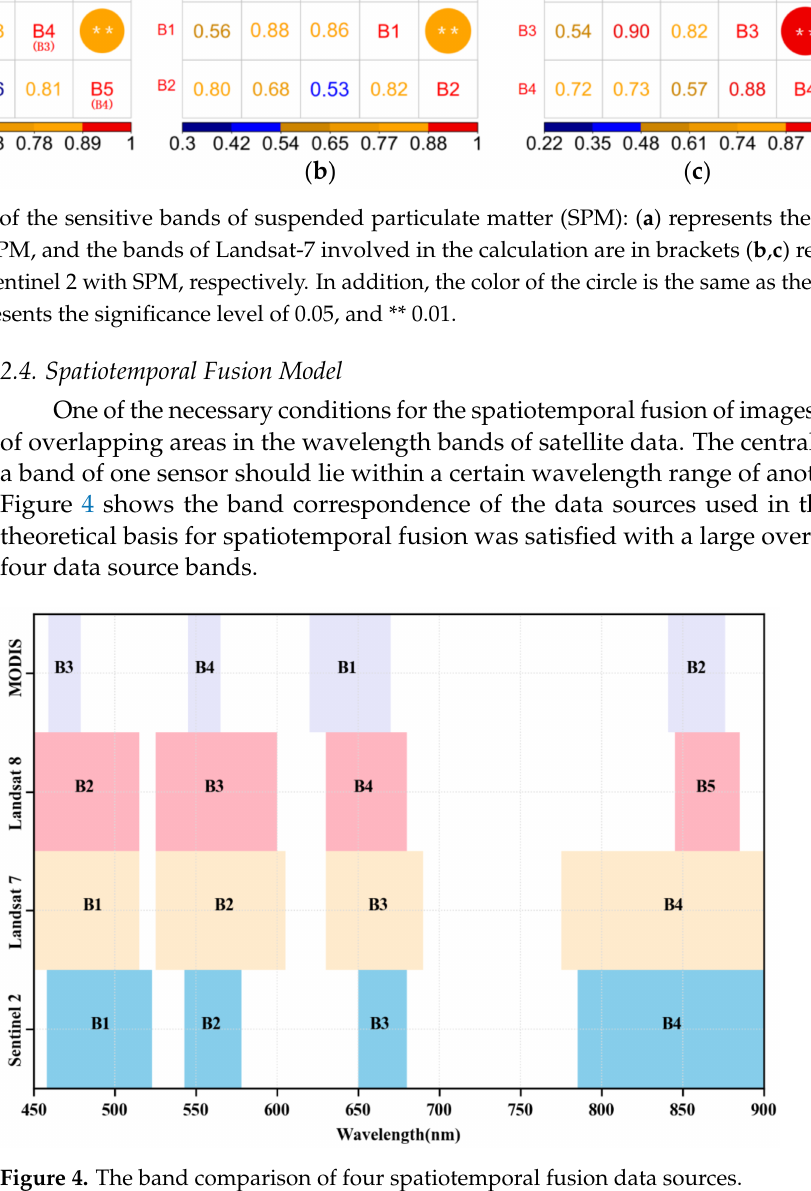
Figure 4. The band comparison of four spatiotemporal fusion data